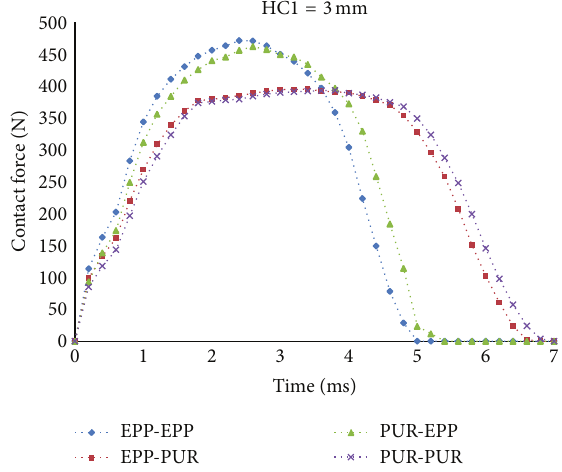
Figure 5: Contact forces of the target with HC1 = 3mm in four cases of